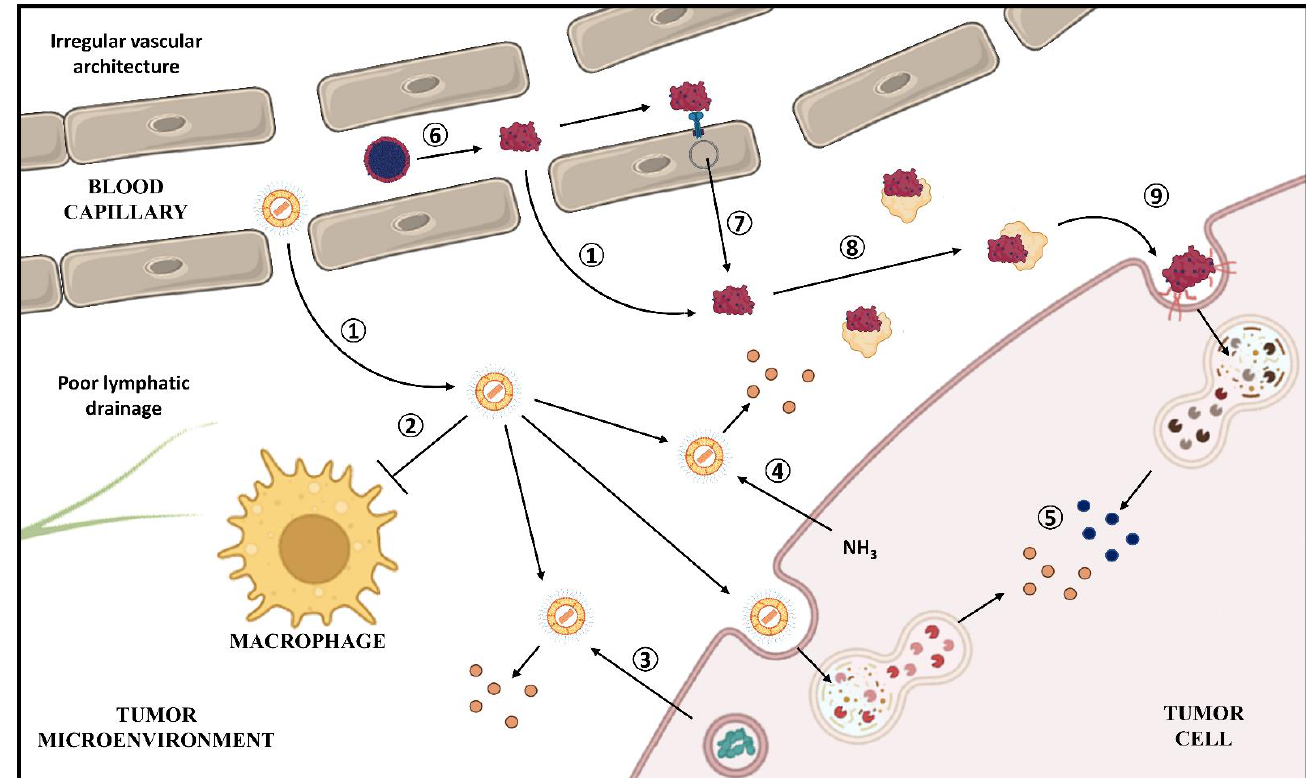
Figure 5. Proposed mechanisms for Doxil ® and Abraxane ® tumor accumulation. After being injected intravenously, the pegylated liposomes of doxorubicin (DOX — orange) formulation may reach the tumor through passive targeting/enhanced permeation-retention (EPR) effect (1), since this site presents irregular vascular architecture with fenestrated capillaries and impaired lymphatic drainage. The presence of polyethylene glycol (PEG) in Doxil ® corona provides a hydration layer that repels opsonins from the liposome and avoids phagocytosis by cells of the reticuloendothelial system (RES), such as macrophages (2). DOX may be released through three distinct mechanisms: secretion of phospholipases (3) or ammonia (4) by tumor cells or endocytosis followed by lysosomal processing (5). Abraxane ® presents other peculiarities: it probably dissociates into smaller complexes composed of albumin and paclitaxel (PTX; blue) (6). These structures, such as Doxil ® , may accumulate in tumor microenvironment, by EPR effect (1), transcytosis through binding receptors (glycoprotein 60 — gp60) in endothelial cells (7), and interaction with secreted protein acidic and rich in cysteine (SPARC — yellow) (8). Albumin may be endocytosed through the caveolin-1 pathway (9), followed by lysosomal processing with subsequent drug release (5). (Created with Biorender.com).